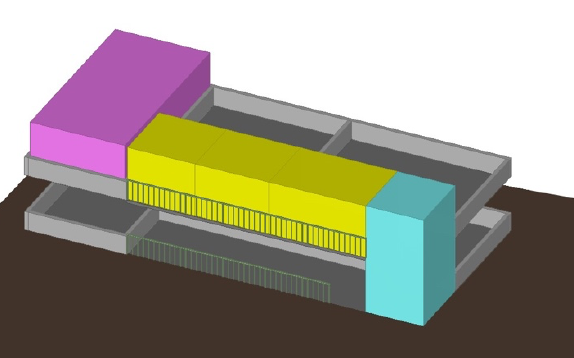
Figure 11. Ground Floor Unit 3 Legal Boundary.